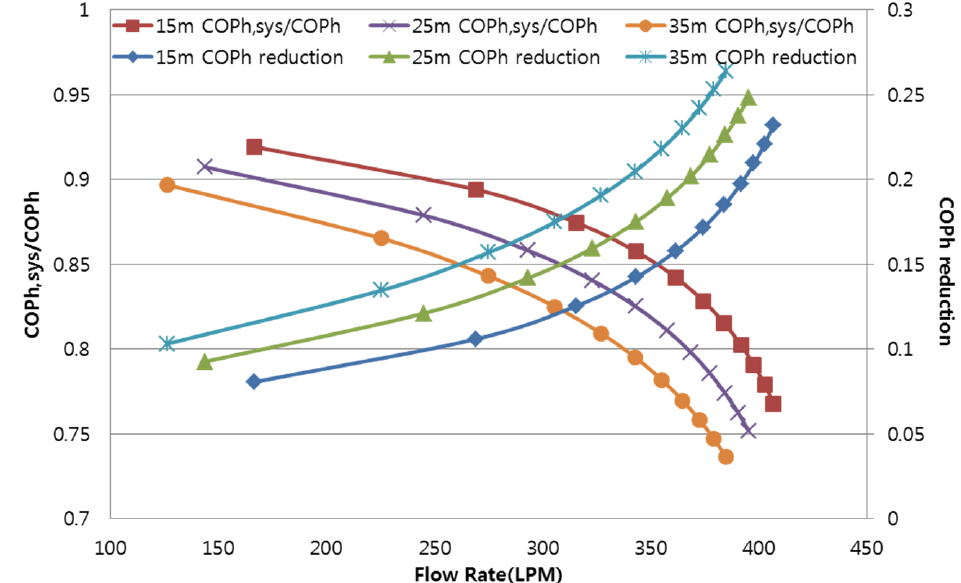
Energies 2016 , 9 , page–page Figure 6. System heating COP reduction compared to heat pump unit COP. Figure 6. System heating COP reduction compared to heat pump unit COP.